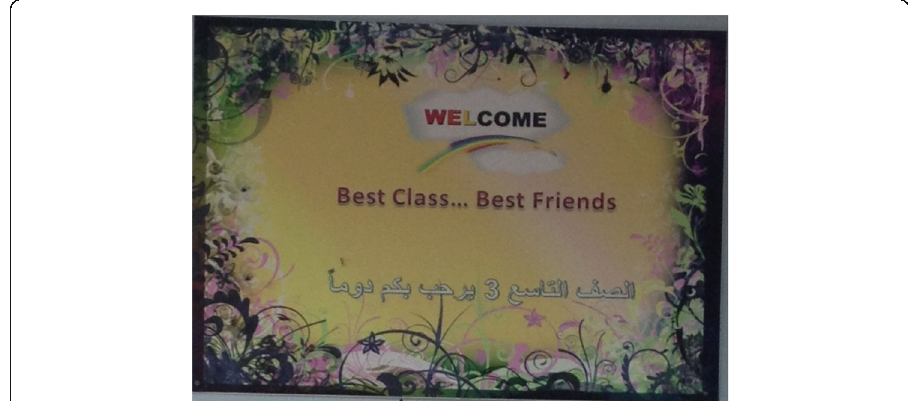
Fig. 6 Arabic-English schoolscape